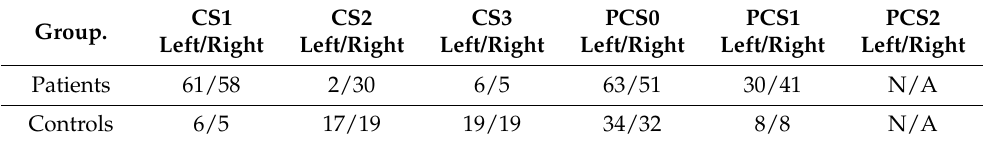
Table 5. Comparison of patients and controls with CS1, 2, and 3 and PCS0, 1, and 2 types of morphology based on Table 3. The numbers show incidences (absolute values) of a particular morphology type in between patients with schizophrenia and controls. N/A—not applicable due to zero or low numbers of